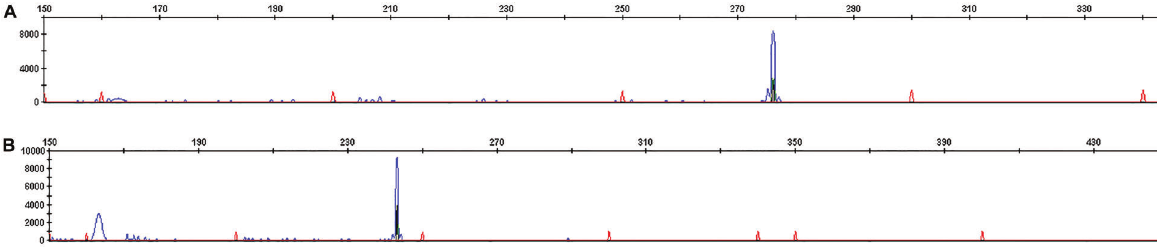
Figure 1. GeneScan of IG rearrangement in a B lineage acute lymphoblastic leukemia patient (P14). A , Monoclonal VH-JH rearrangement; B , monoclonal VK-Kde rearrangement.